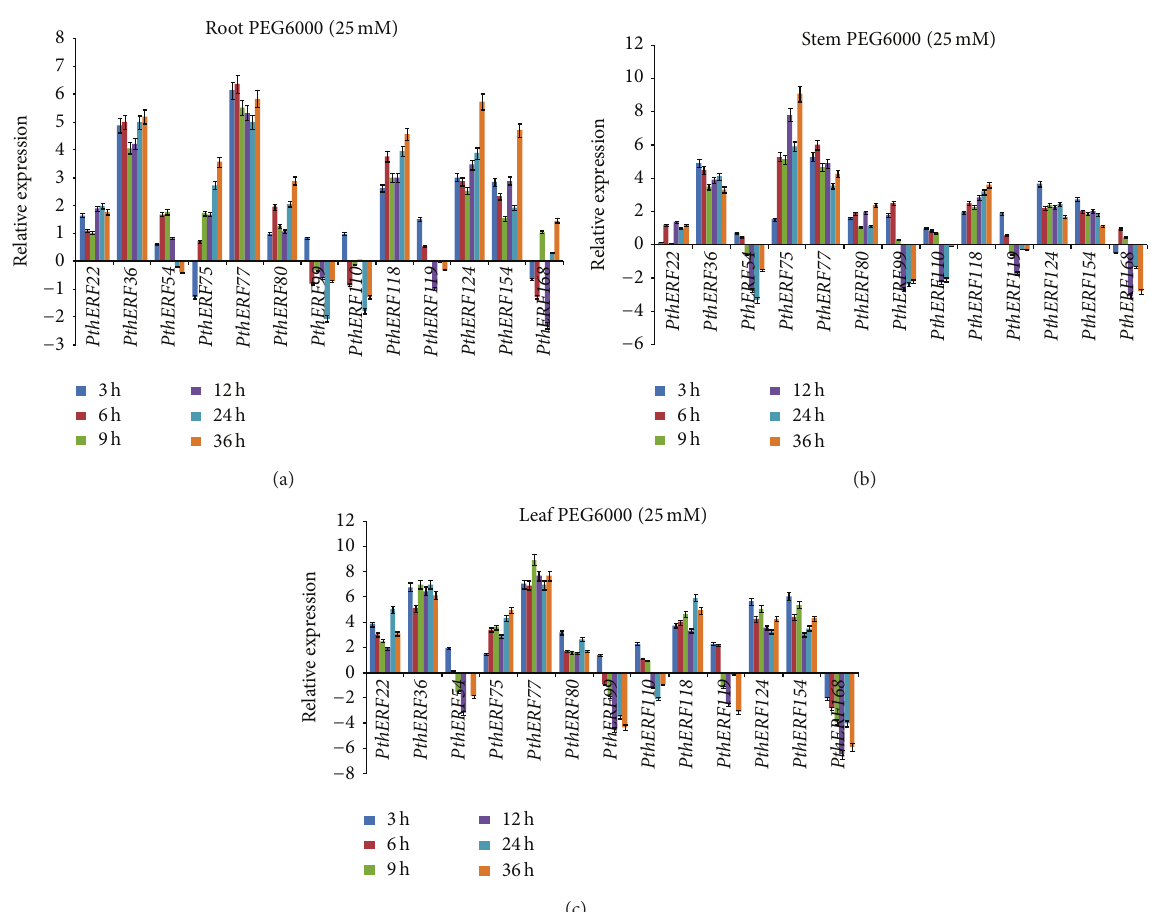
Figure 4: Spatial-temporal expression of 13 PthERFs under drought stress in different tissues. Relative expression level was log 2 transformed: > 0, upregulation; =0, no change in regulation; < 0, downregulation: (a) in roots; (b) in stems; (c) in leaves.